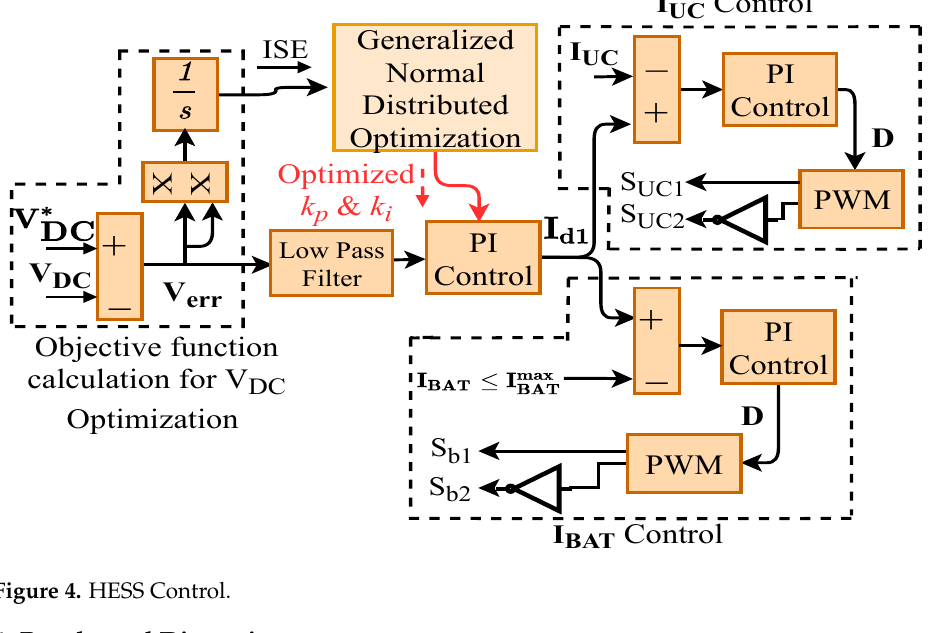
Figure 4. HESS Control.